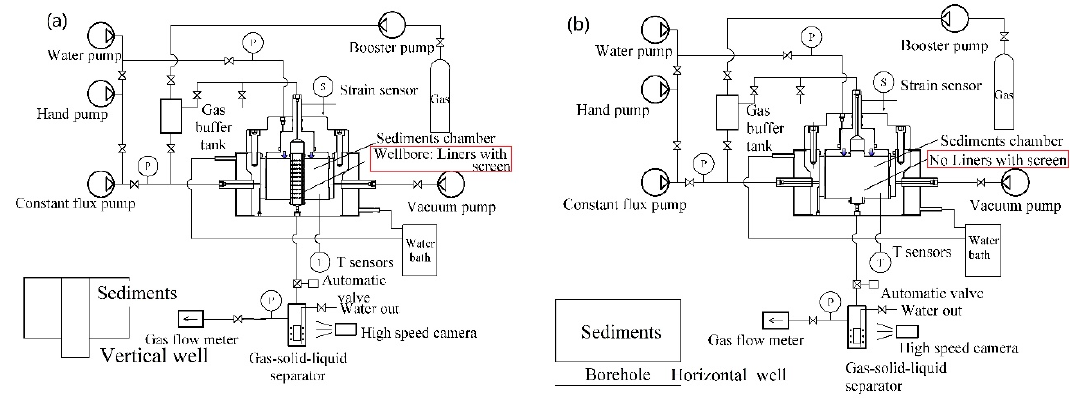
Figure 1. Diagram of the sand production facility for ( a ) a vertical well [27] and ( b ) a horizontal well.